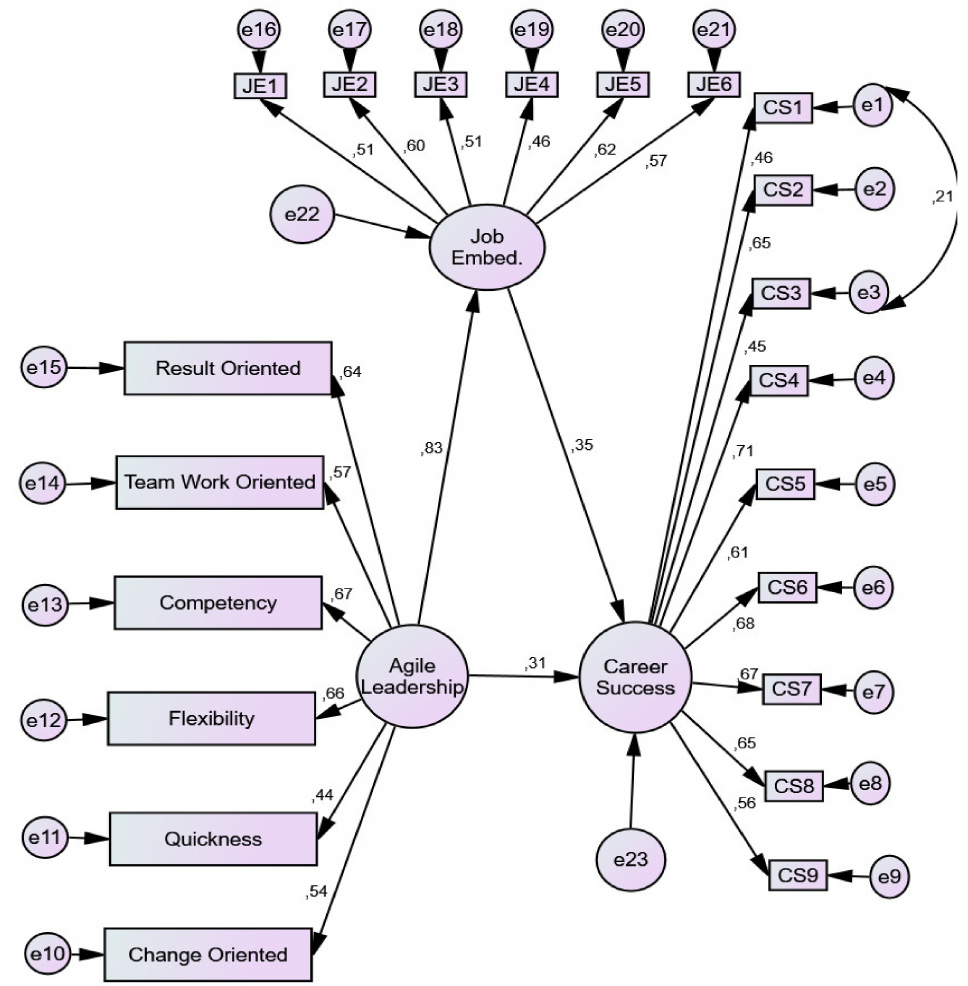
Figure 3. Regression coefficient between all constructs.